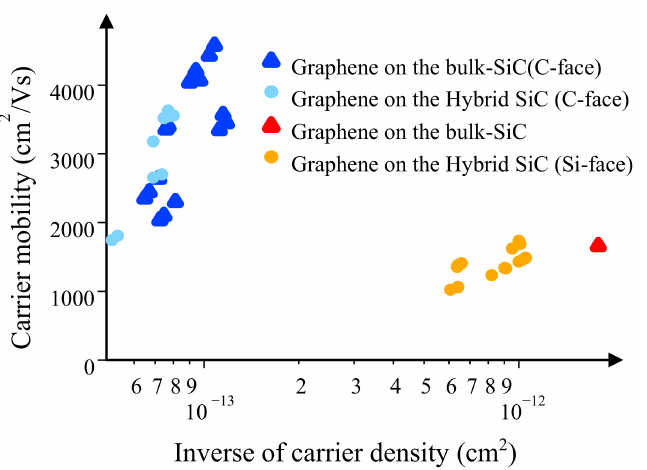
Figure 4. Hall-effect mobility measurements of FLG on the C-face and Si-face hybrid SiC and SiC bulk crystal at room